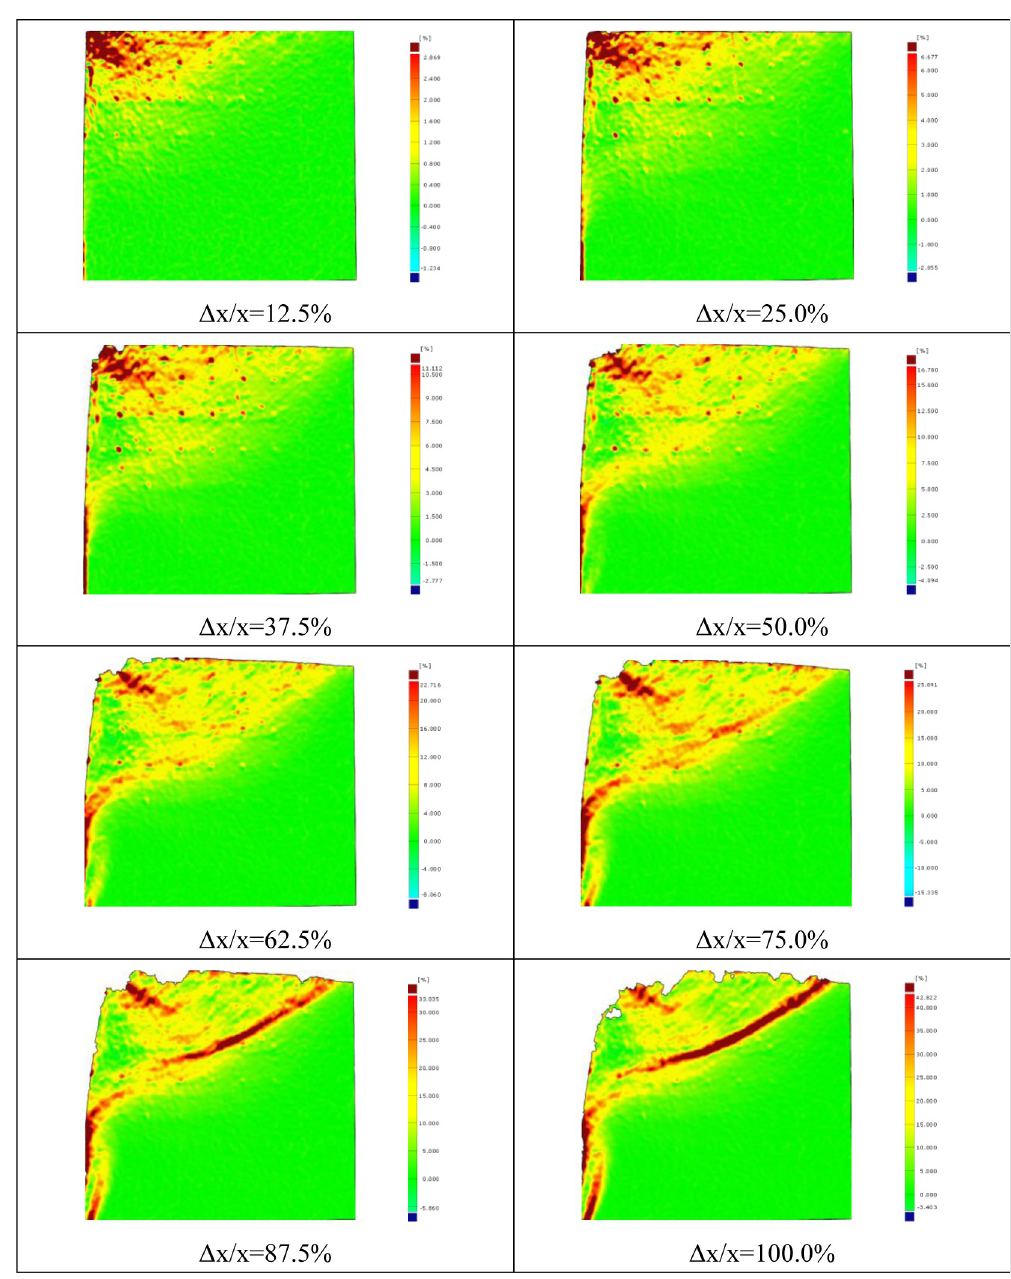
Fig 6. Shear strain nephogram of soil at different stages